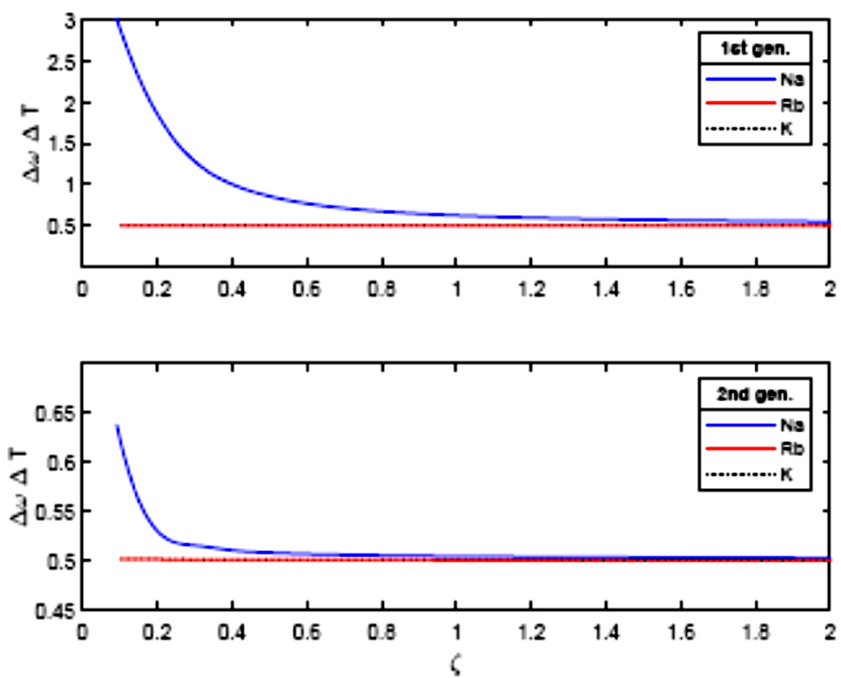
Figure 5. Pulse shaping and temporal behaviour of the field’s amplitude absolute value in probe and the drive channels.